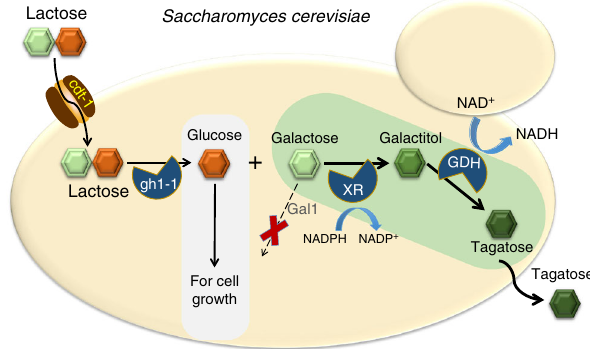
Fig. 6 Schematic diagram of the production of tagatose from lactose in engineered S. cerevisiae . Heterologous expression of cdt-1 (cellobiose transporter), gh1-1 ( β -glucosidase), XR (xylose reductase), GDH (galactitol- 2-dehydrogeanse), and deletion of Gal1 (galactose kinase) were combined in S. cerevisiae to produce tagatose directly from